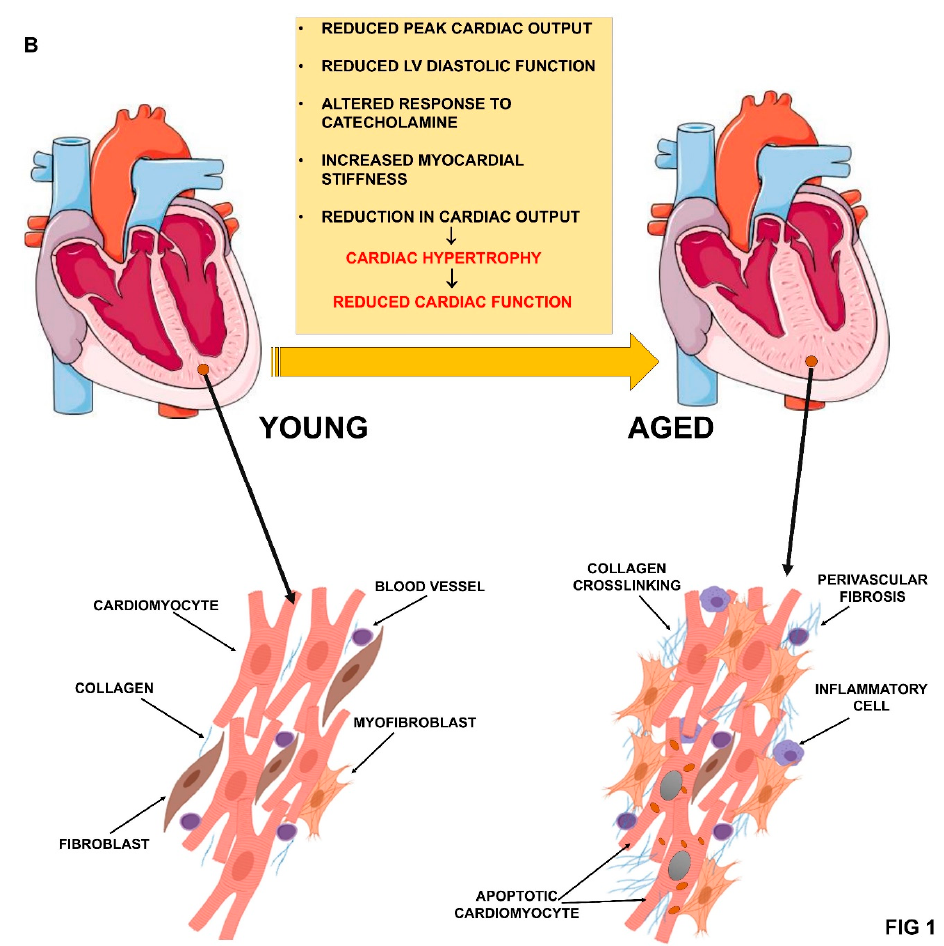
Figure 1. Cardiovascular function deterioration by ageing. ( A ) Vascular function impairment by ageing.